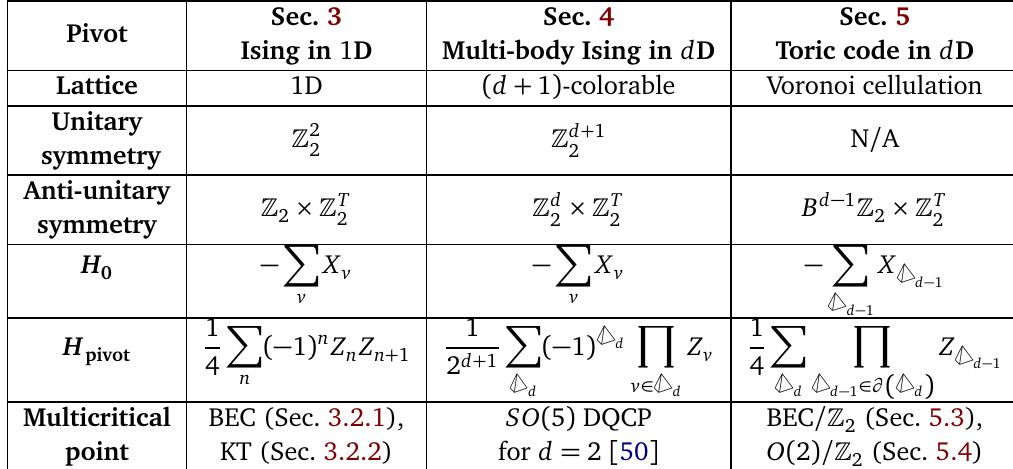
, the ground state of the 0